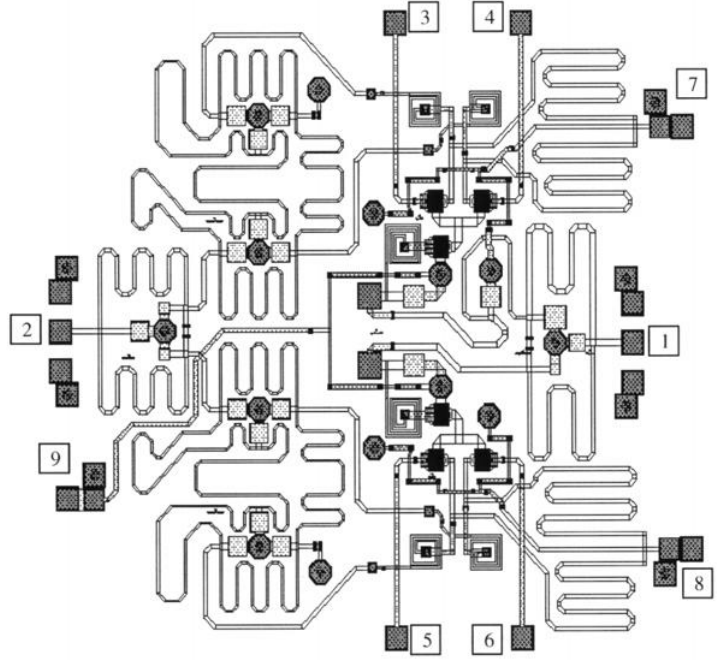
FIGURE 25 Final layout of the QPSK modulator.